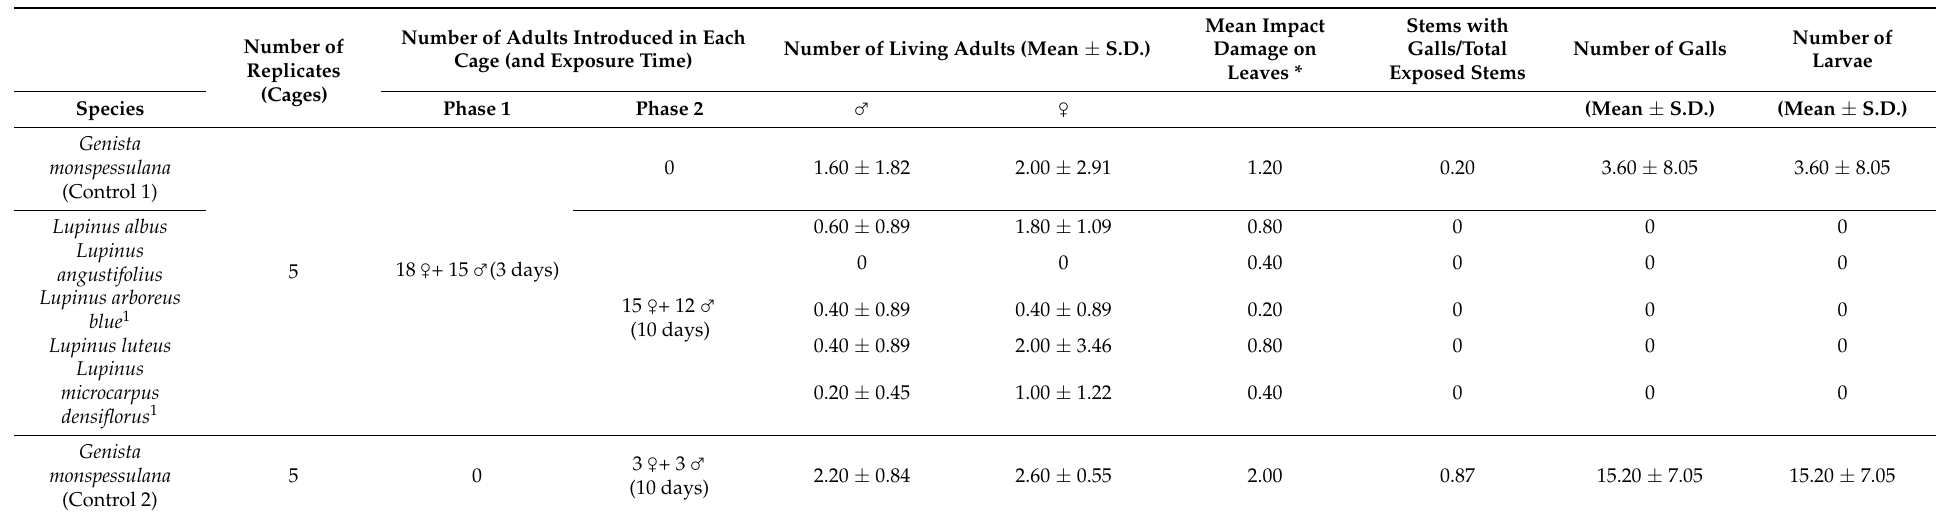
Table 4. Choice tests on stems of test plants for Lepidapion argentatum including adult survival during exposure, adult feeding damage, and oviposition in stems of five lupine species and one G. monspessulana plant per cage exposed for three days with 18 females and 15 males (phase 1) followed by 10 days with 15 females and 12 males (phase